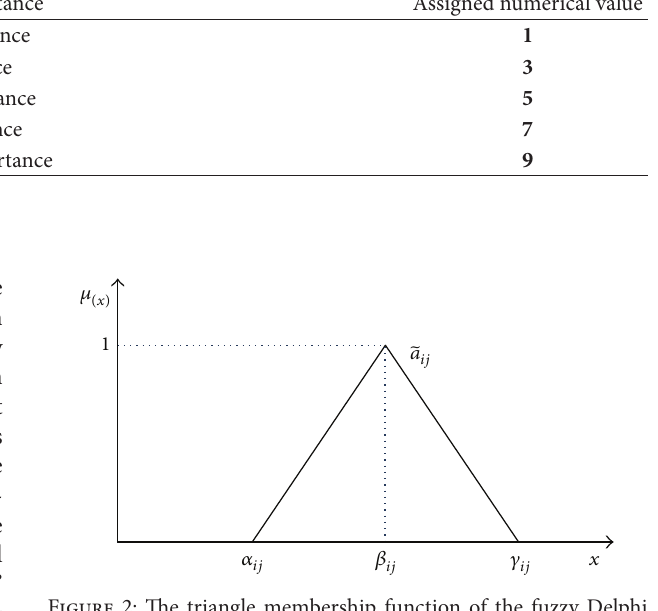
Figure 2: The triangle membership function of the fuzzy Delphi